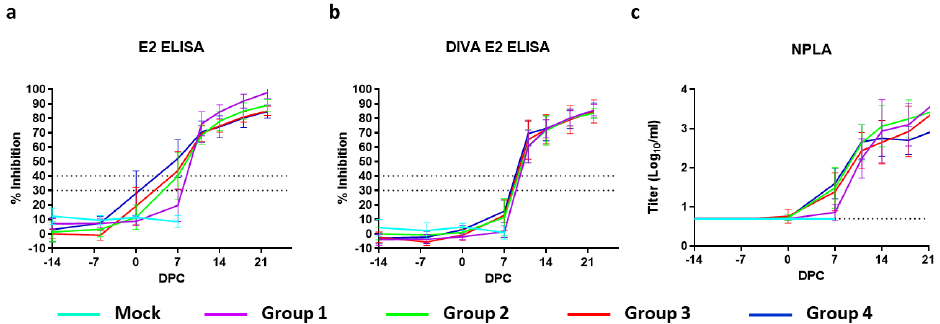
Figure 4. Detection and antibodies by E2 (DIVA) ELISA and NPLA. Results are presented as mean antibody levels (% Inhibition) as determined by the IDEXX E2 ELISA ( a ) and the DIVA E2 ELISA ( b ). Cut-offs (dotted lines) were set at 40% inhibition; ≥ 30%: doubtful, ≥ 40%: positive. The cut-off of the NPLA ( c ) was set at 0.7. Error bars represent SD.